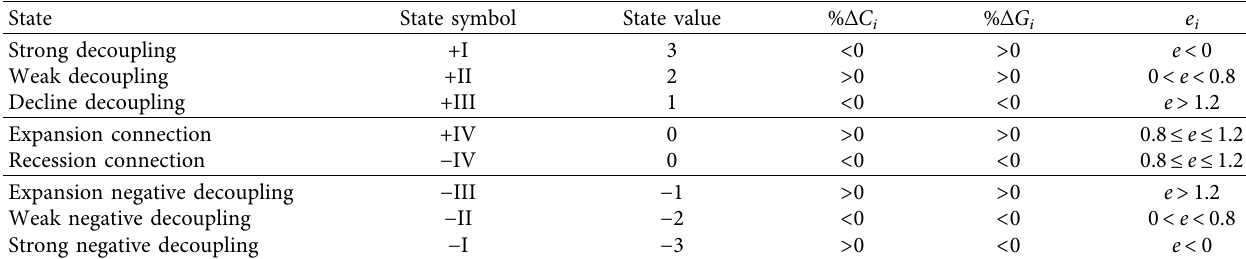
Table 2: Analysis model of decoupling state of carbon emission.